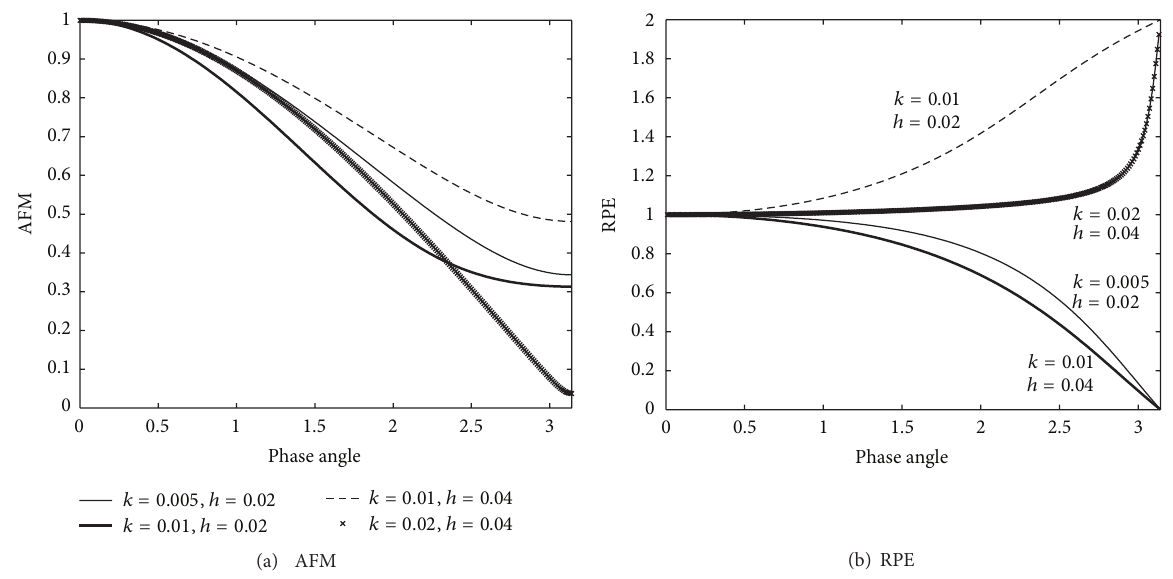
Figure 6: Plot of AFM and RPE versus phase angle for the NSFD